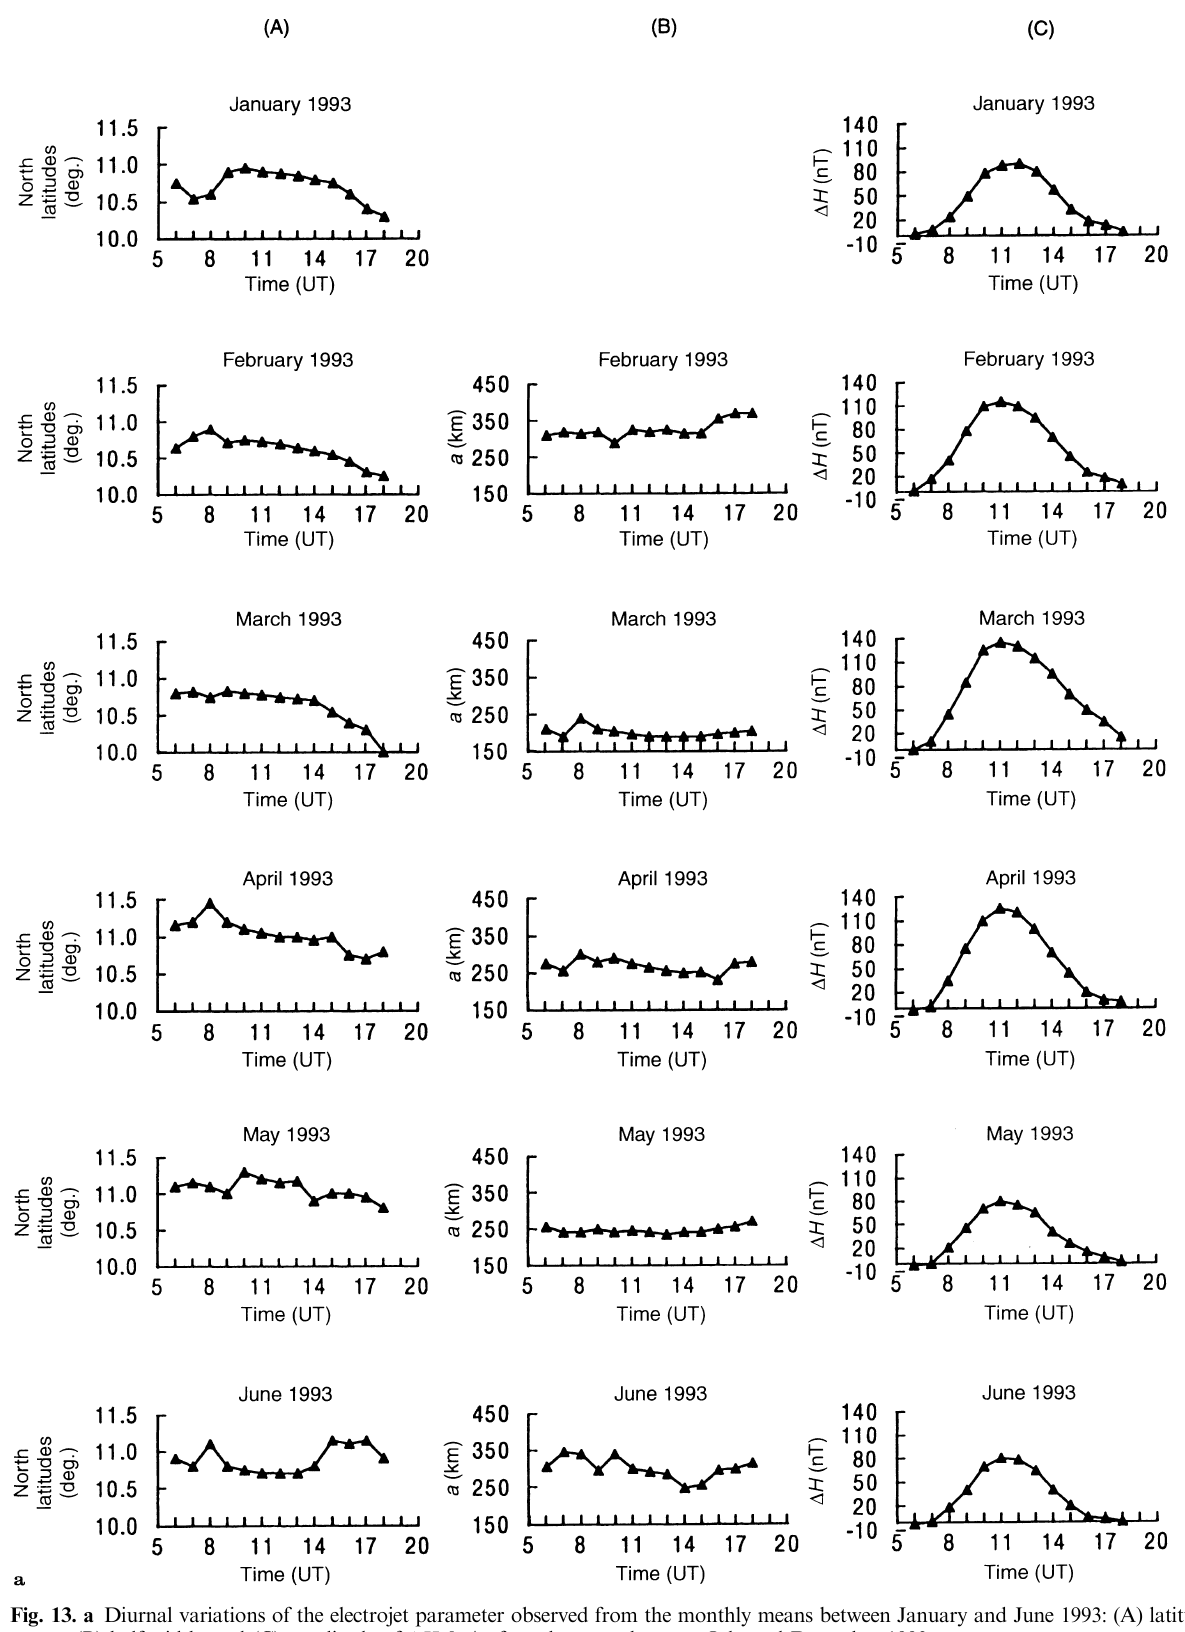
Fig. 13. a Diurnal variations of the electrojet parameter observed from the monthly means between January and June 1993: (A) latitude of the center, (B) half width, and (C) amplitude of (cid:68) H . b As for a but now between July and